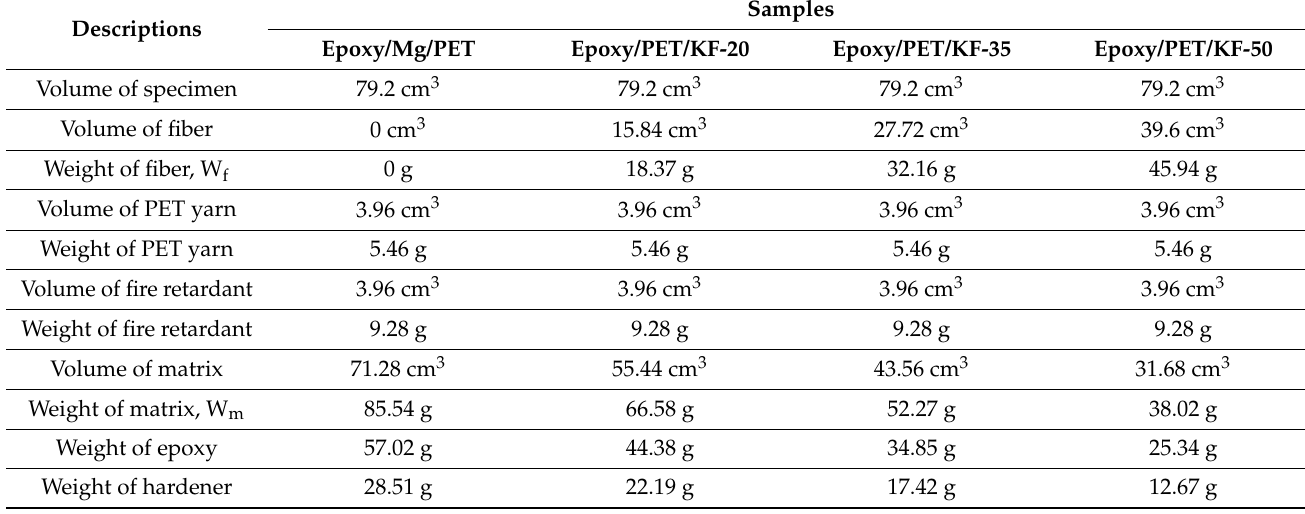
Table 4. Results of the calculation for all